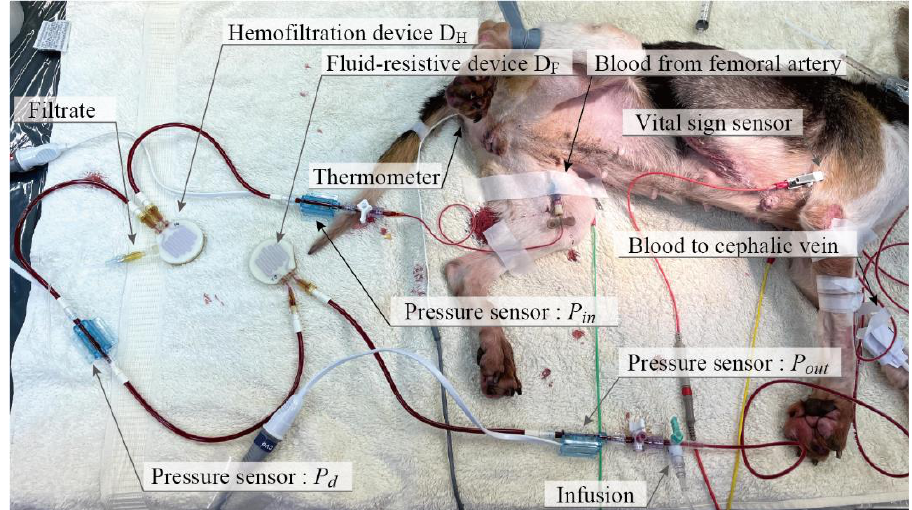
Figure 9. Photograph of an ex vivo experiment with a beagle dog. The animal is under anesthesia. The devices are connected to the femoral artery and cephalic vein. Filtrate is collected while pressures P in , P out , and P d are continuously measured. Vital signals including P a and P v are also recorded. Blood is collected to measure C TP and deduce P c . Table 1. Basic information on the 3 beagle dogs (A, B, C).